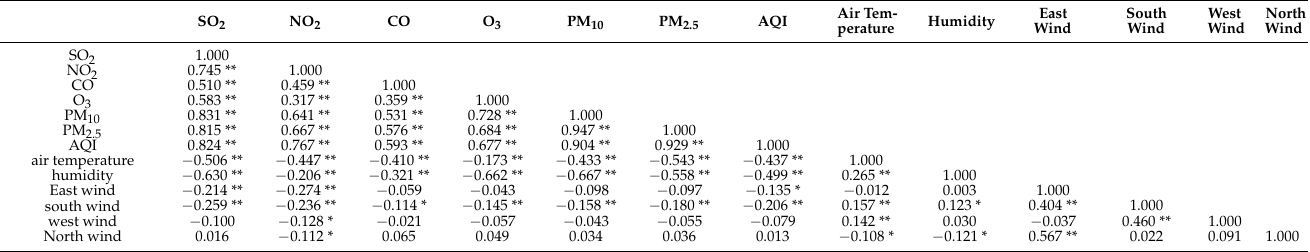
Table 2. Spearman correlation analysis results of air pollutant concentration in Shenzhen city with meteorological factors and wind